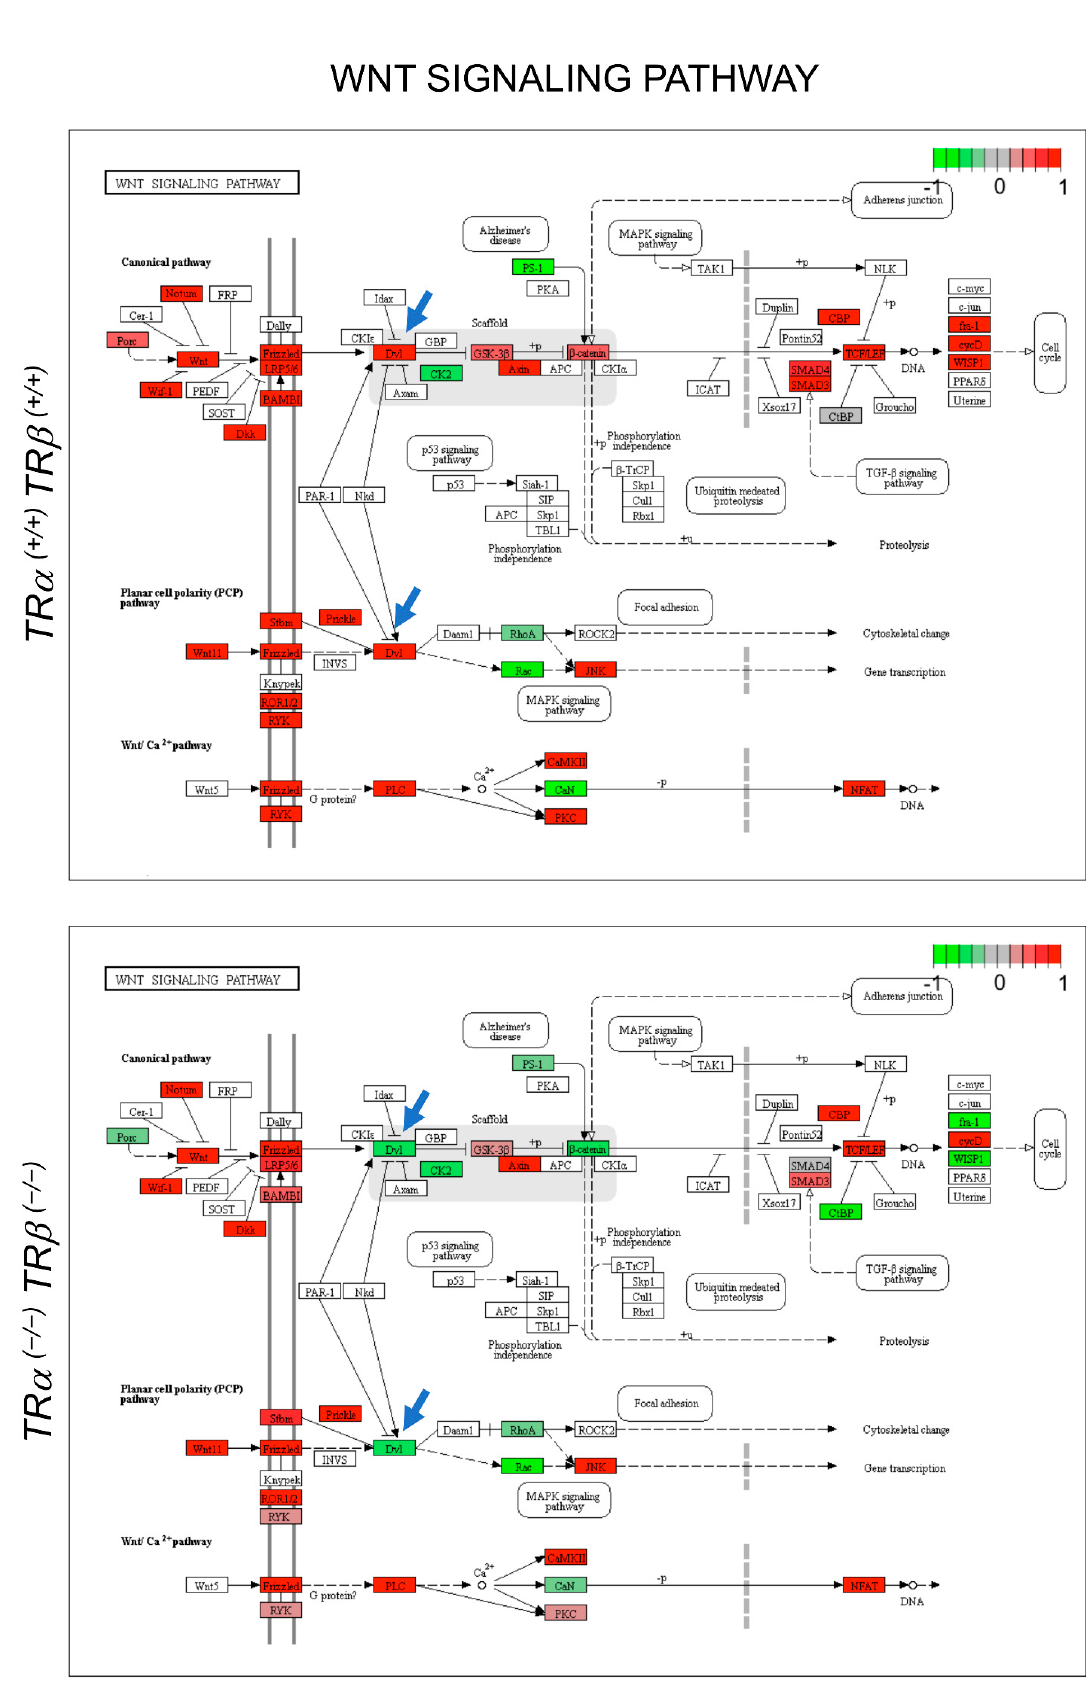
Figure 7. TR-dependent regulation of genes in the Wnt signaling pathway, a representative pathway likely involved in the development of adult intestinal stem cells, as revealed by RNA-seq analysis. Up- and down-regulated genes in the